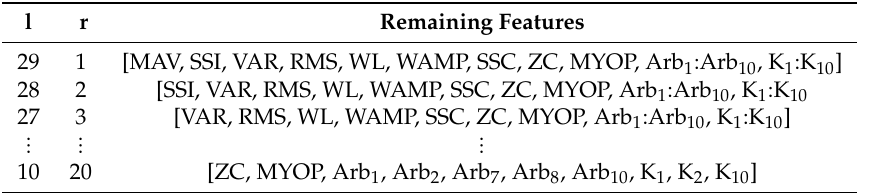
Table 3. Feature reduction process. MAV, mean average value; SSI, simple squared integration; WL, wavelength; WAMP, Willison amplitude; MYOP, myopulse percentage